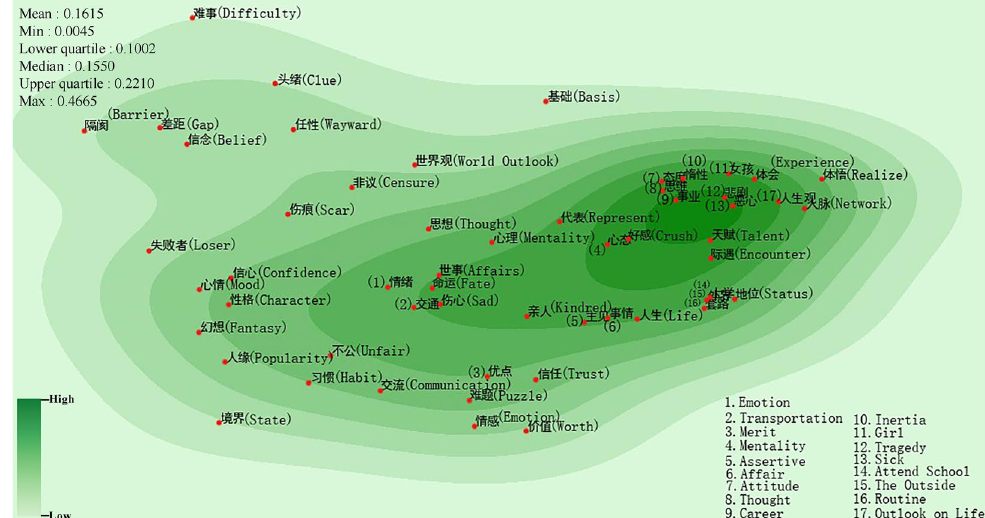
Figure 2. Semantic map of inferiority feelings about personal experience (Drawing with Seaborn 0.8.1 in python 36,37 ).